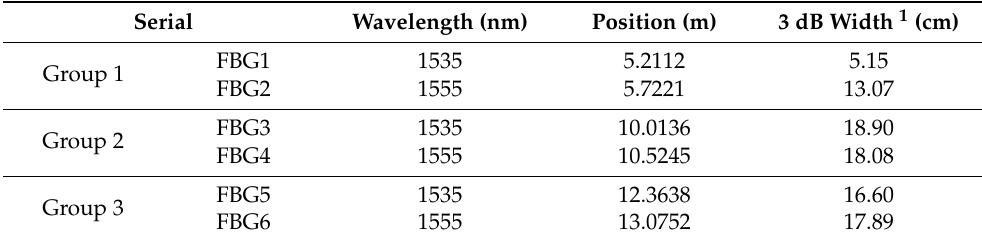
Figure 3. Demodulation process of beat frequency signal: ( a ) the original beat frequency signal; ( b ) location information corresponding to the beat frequency signal; ( c ) demodulation results for sensor group 1; ( d ) demodulation results for sensor group 2; ( e ) demodulation results for sensor group 3. Table 1. Basic parameters of multiplexed